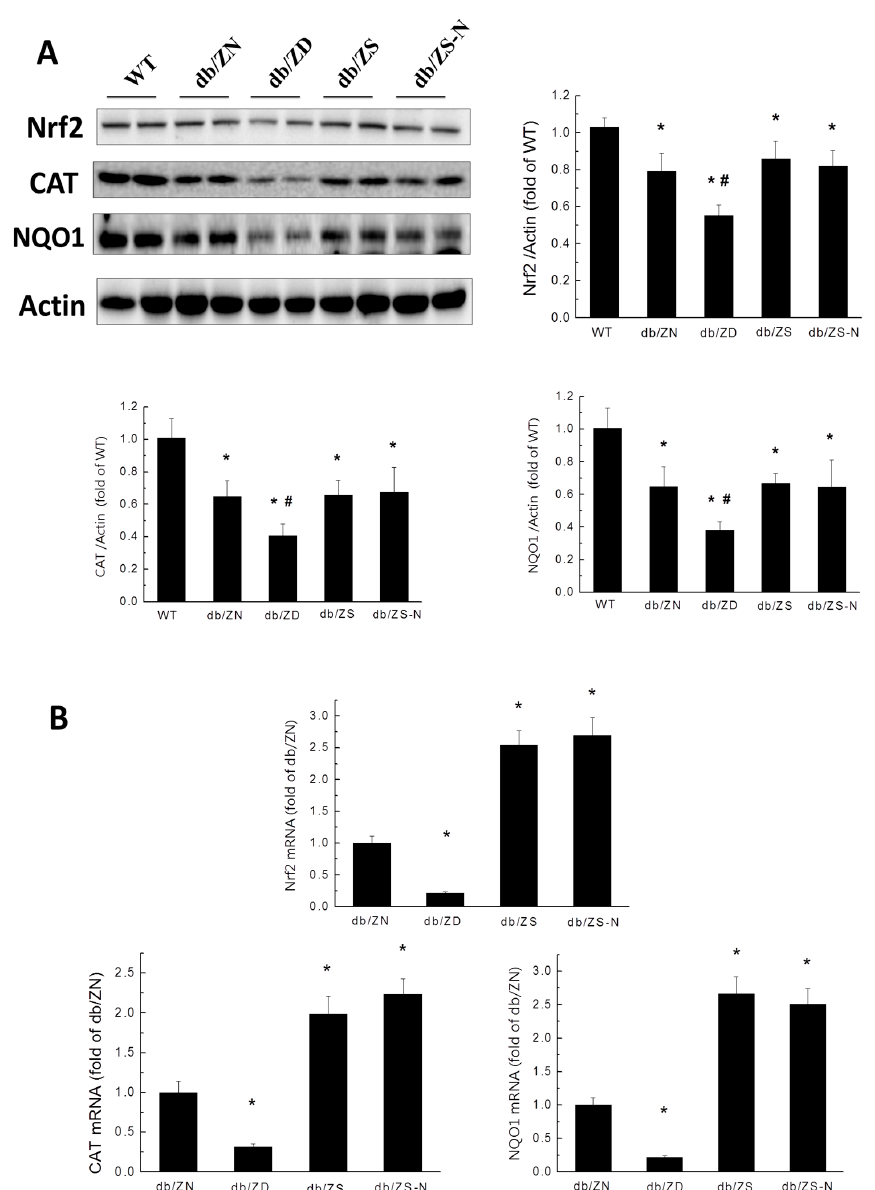
Figure 6. Effects of Zn deficiency and supplementation on T2DM-induced downregulation of Nrf2 and downstream genes in db/db mice. The expression levels of Nrf2 protein and downstream factors, such as catalase and NAD(P)H dehydrogenase 1( NQO-1), were examined by Western blot ( A ) and RT-PCR ( B ). Data were presented as mean ± SD ( n = 4–7, details in Figure 1). *, p < 0.05 vs. WT group; #, p < 0.05 vs. db/ZN group.